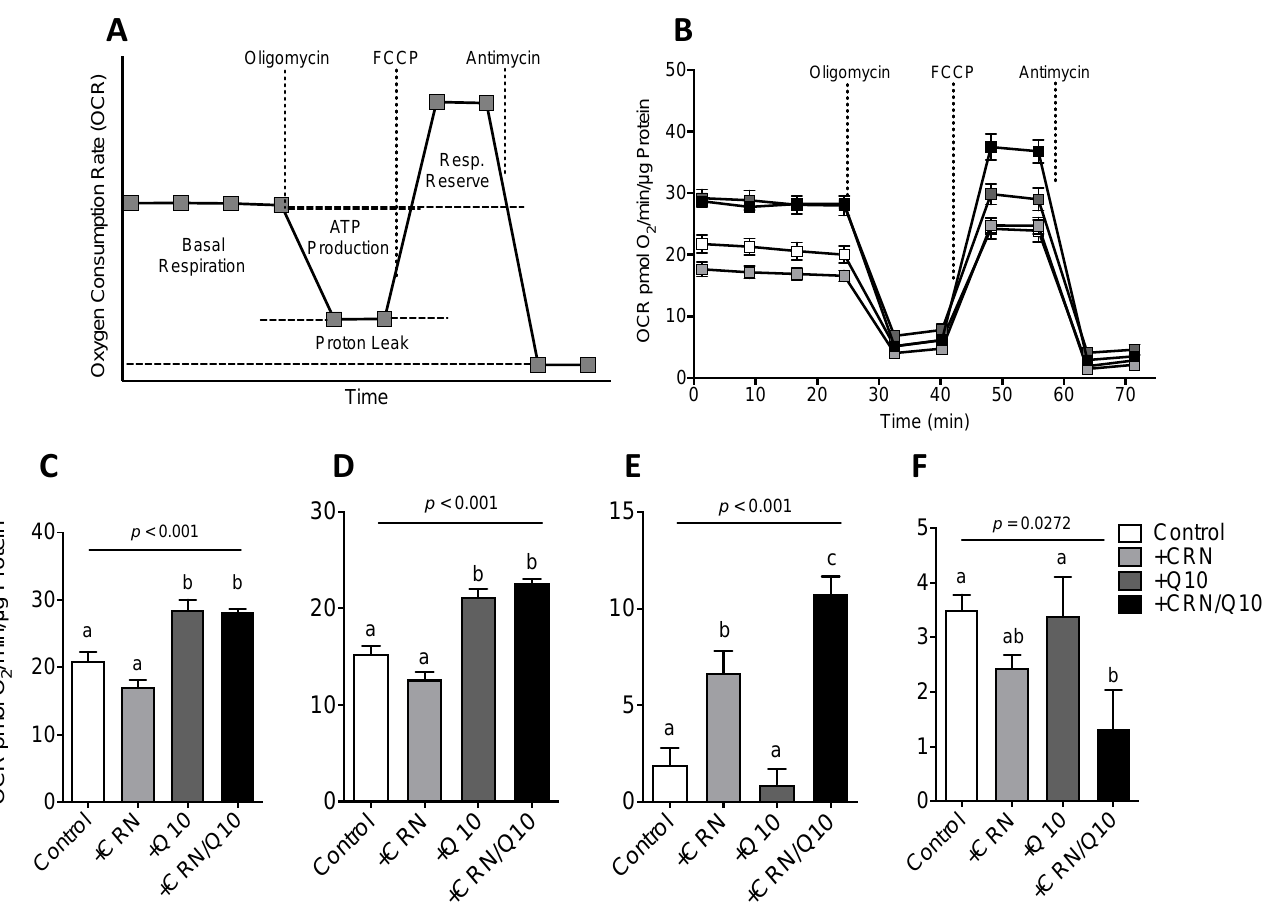
Figure 3. Schematic diagram of a standard OCR readout plot with output parameters pertaining to oxphos metabolism labeled ( A ); Sample HepG2 XF24 respirometry assay OCR readout from a single experiment with intra-repeat variation ( B ); Basal respiration OCR levels, inferred through the average of four baseline measurements minus non-mitochondrial respiration levels ( C ); ATP production, calculated as the difference between baseline respiration and OCR after oligomycin injection ( D ); Respiratory reserve, calculated as the difference between maximal OCR after FCCP injection and basal respiration ( E ); Proton leak, calculated as the difference between OCR after oligomycin injection and residual non-mitochondrial respiration measured as OCR after Antimycin A injection ( F ). Results are normalized to total protein content per well and expressed as pmol O2/min/µm protein. Results are compiled from 4 separate experiments. All values are represented as mean ± SEM. Statistical analysis was performed using one-way ANOVA with multiple comparison differences denoted. A p -value of <0.05 was considered significant. (a,b) Different letters indicate significant differences in mean values from repeated-measures ANOVA ( p < 0.05).